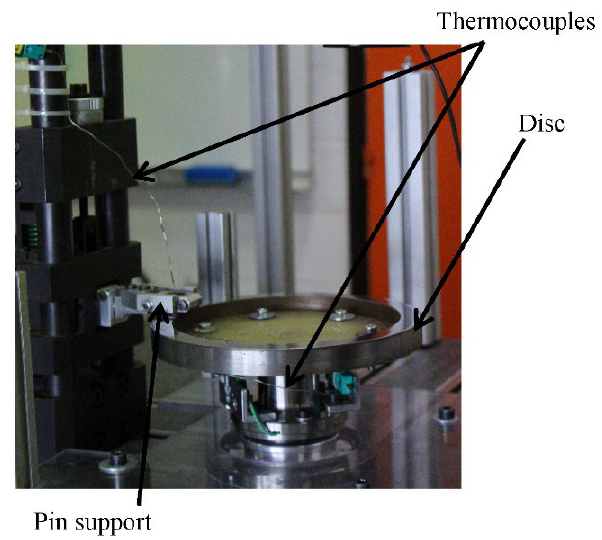
Figure 2. Pin-on-disc tribometer.